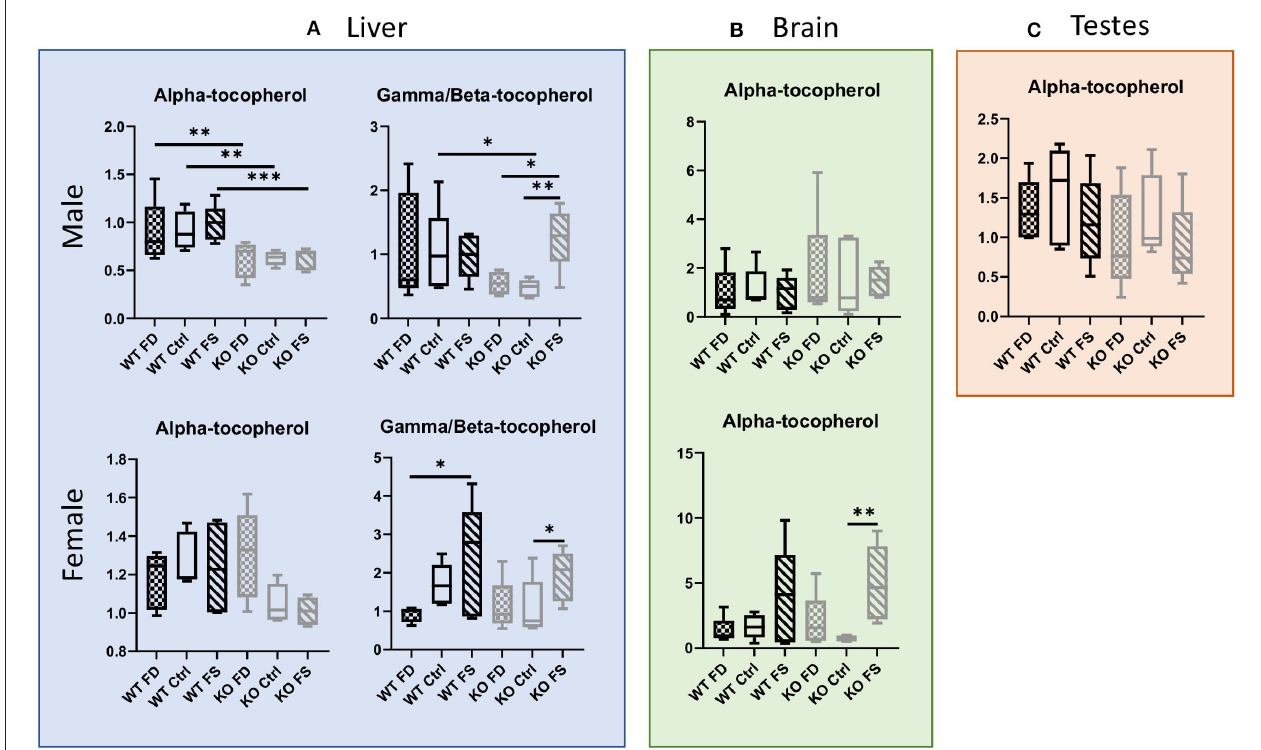
FIGURE 2 | Loss of CerS6 in males resulted in significantly lower concentrations of alpha-tocopherol and a trend for lower gamma/beta-tocopherol, which was rescued by (A) FS diet. No significant differences between groups were seen in testes (C) . Female liver (A) and brain (B) showed increase in gamma/beta-tocopherol with FS diet. Data show minimum and maximum, with bar at median value, n = 5. Checked bars, FD diet; solid bars, Ctrl diet; striped bars, FS diet. WT is shown in black, and KO is shown in gray. * p < 0.05; ** p < 0.01; *** p < 0.001; determined by ANOVA comparisons.